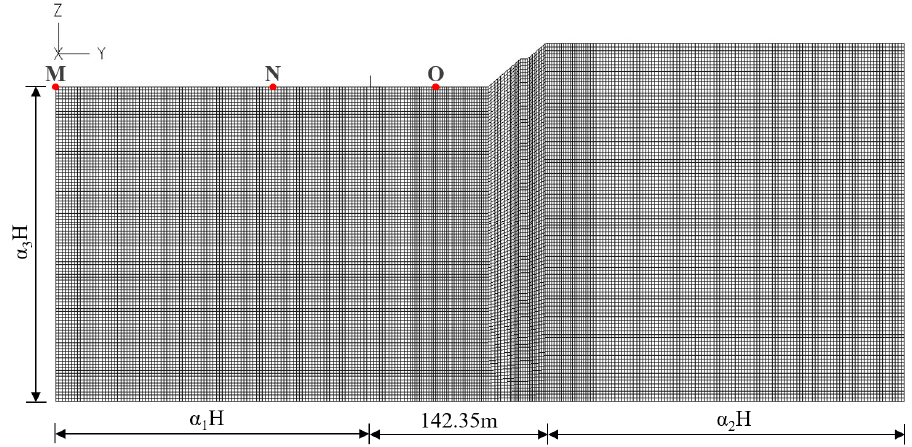
Figure 11. The finite element model of the foundation. Table 5. The PGA values at the observation points under sinusoidal excitation (m/s 2 ). Foundation